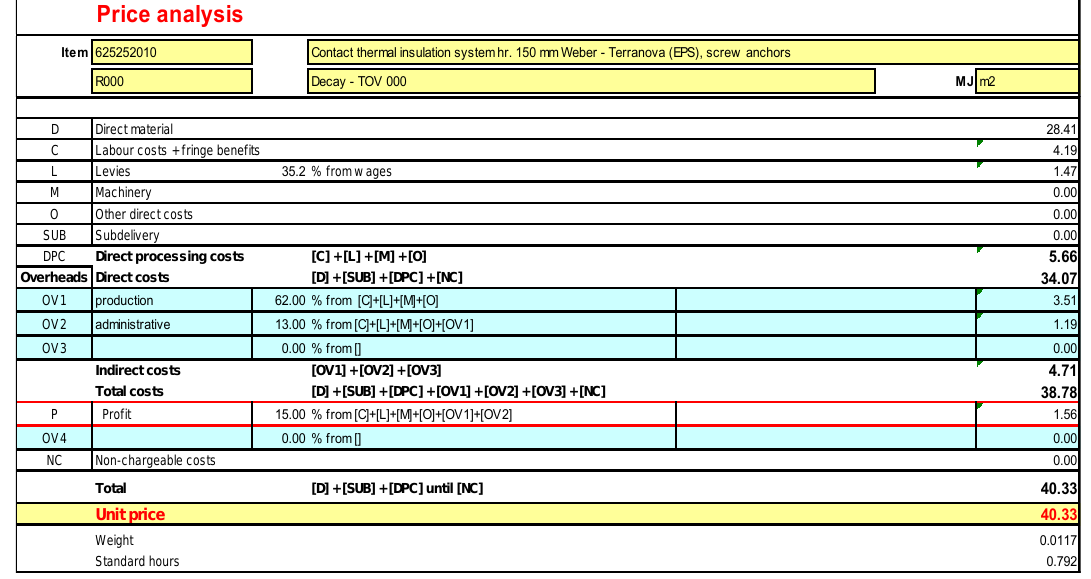
Figure 2. Calculated profit according to the Calculation Formula (CF) methodology.